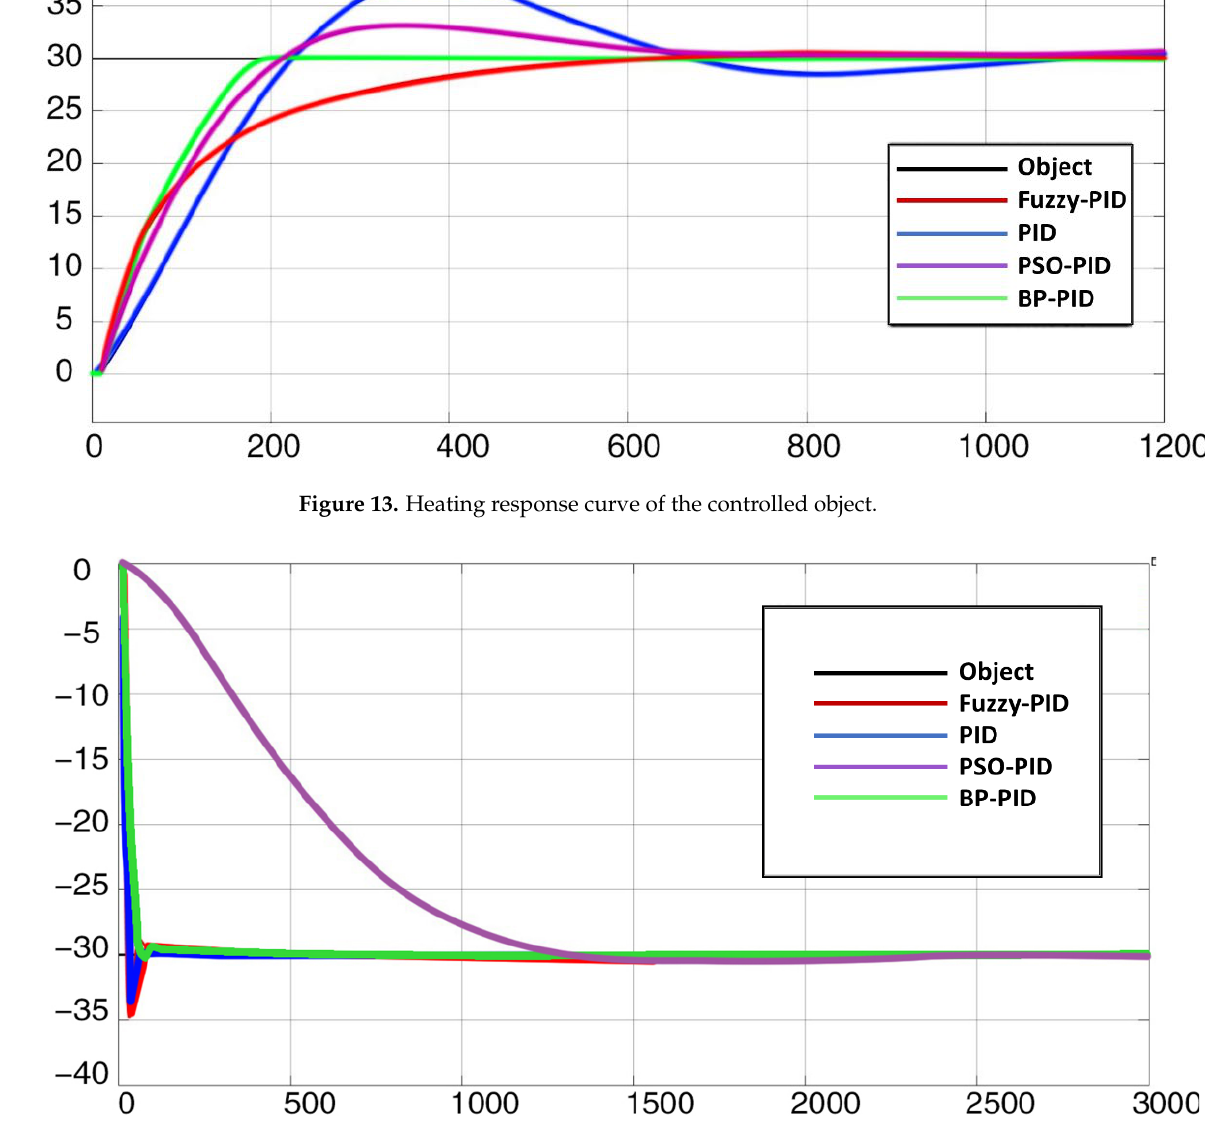
Figure 14. Cooling response curve of the controlled object.